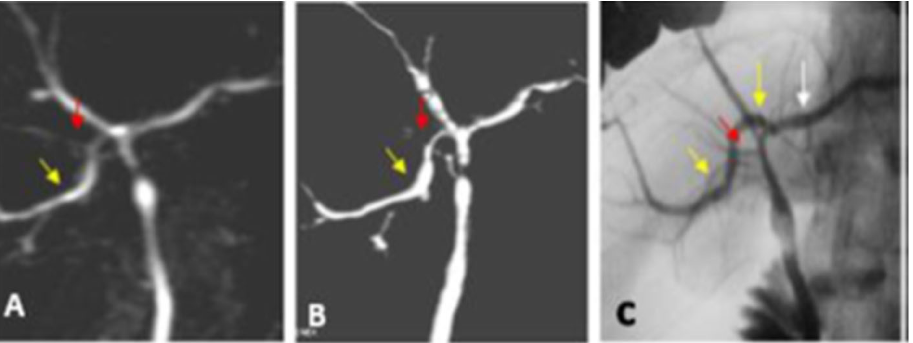
Figure 4. Type III ‐ b intrahepatic biliary variant. ( A ) 2D coronal oblique thin slap heavy T2 FAT SAT FSE image. ( B ) Anterior view of post ‐ processed 3D VR coronal image shows the insertion of the RPSD (yellow arrow) into the middle part of the CHD (red arrow) above the cystic duct. ( C ) IOC AP view image confirms the MRCP findings and shows the insertion of the RPSD (yellow arrow) into the middle part of the common hepatic duct.